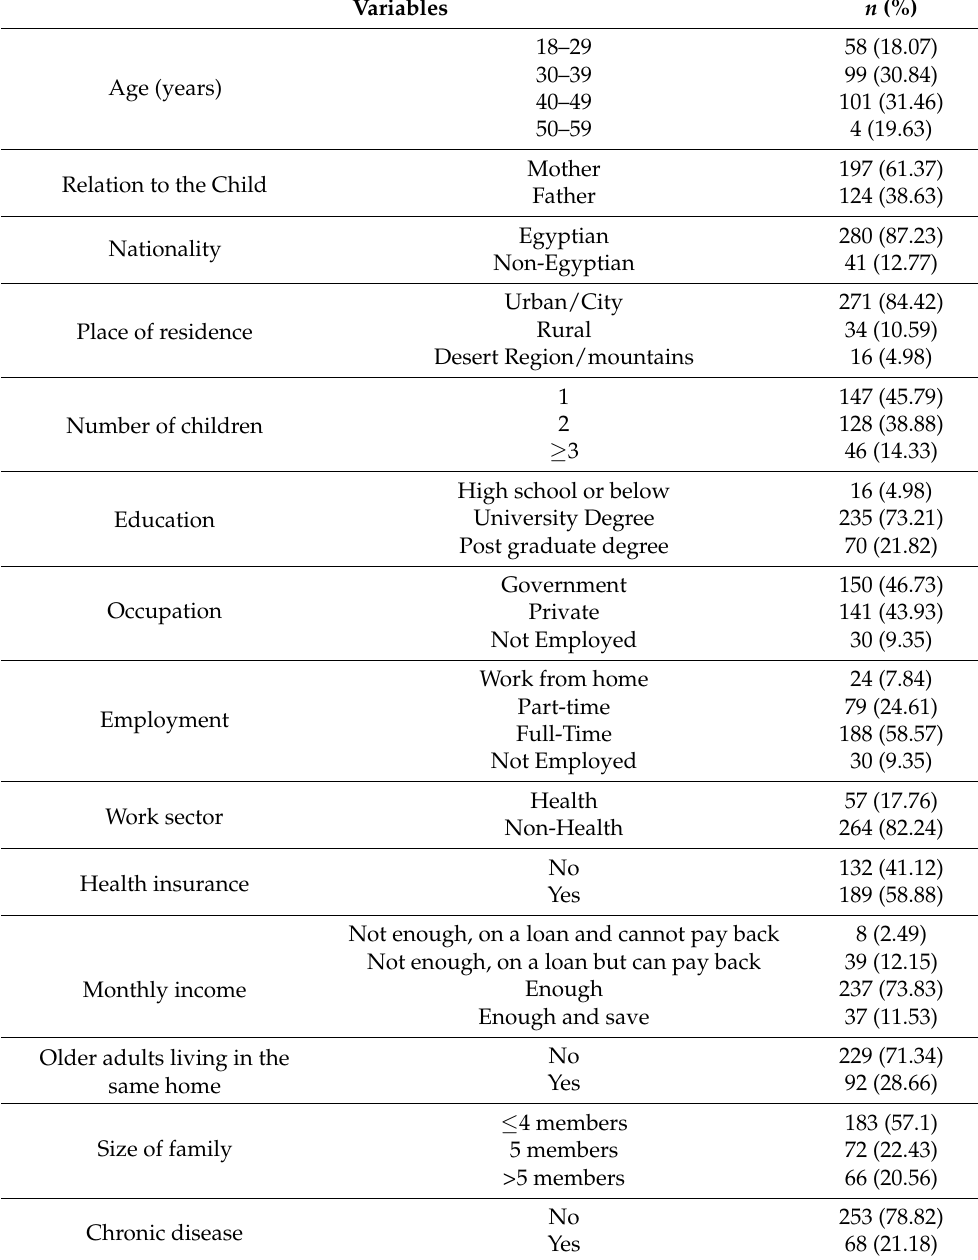
Table 1. Characteristics of the parents ( n =